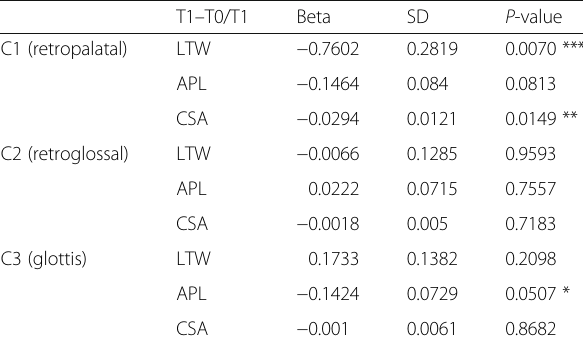
Table 5 The correlation of the proportion of difference between before and after surgery to the values before surgery